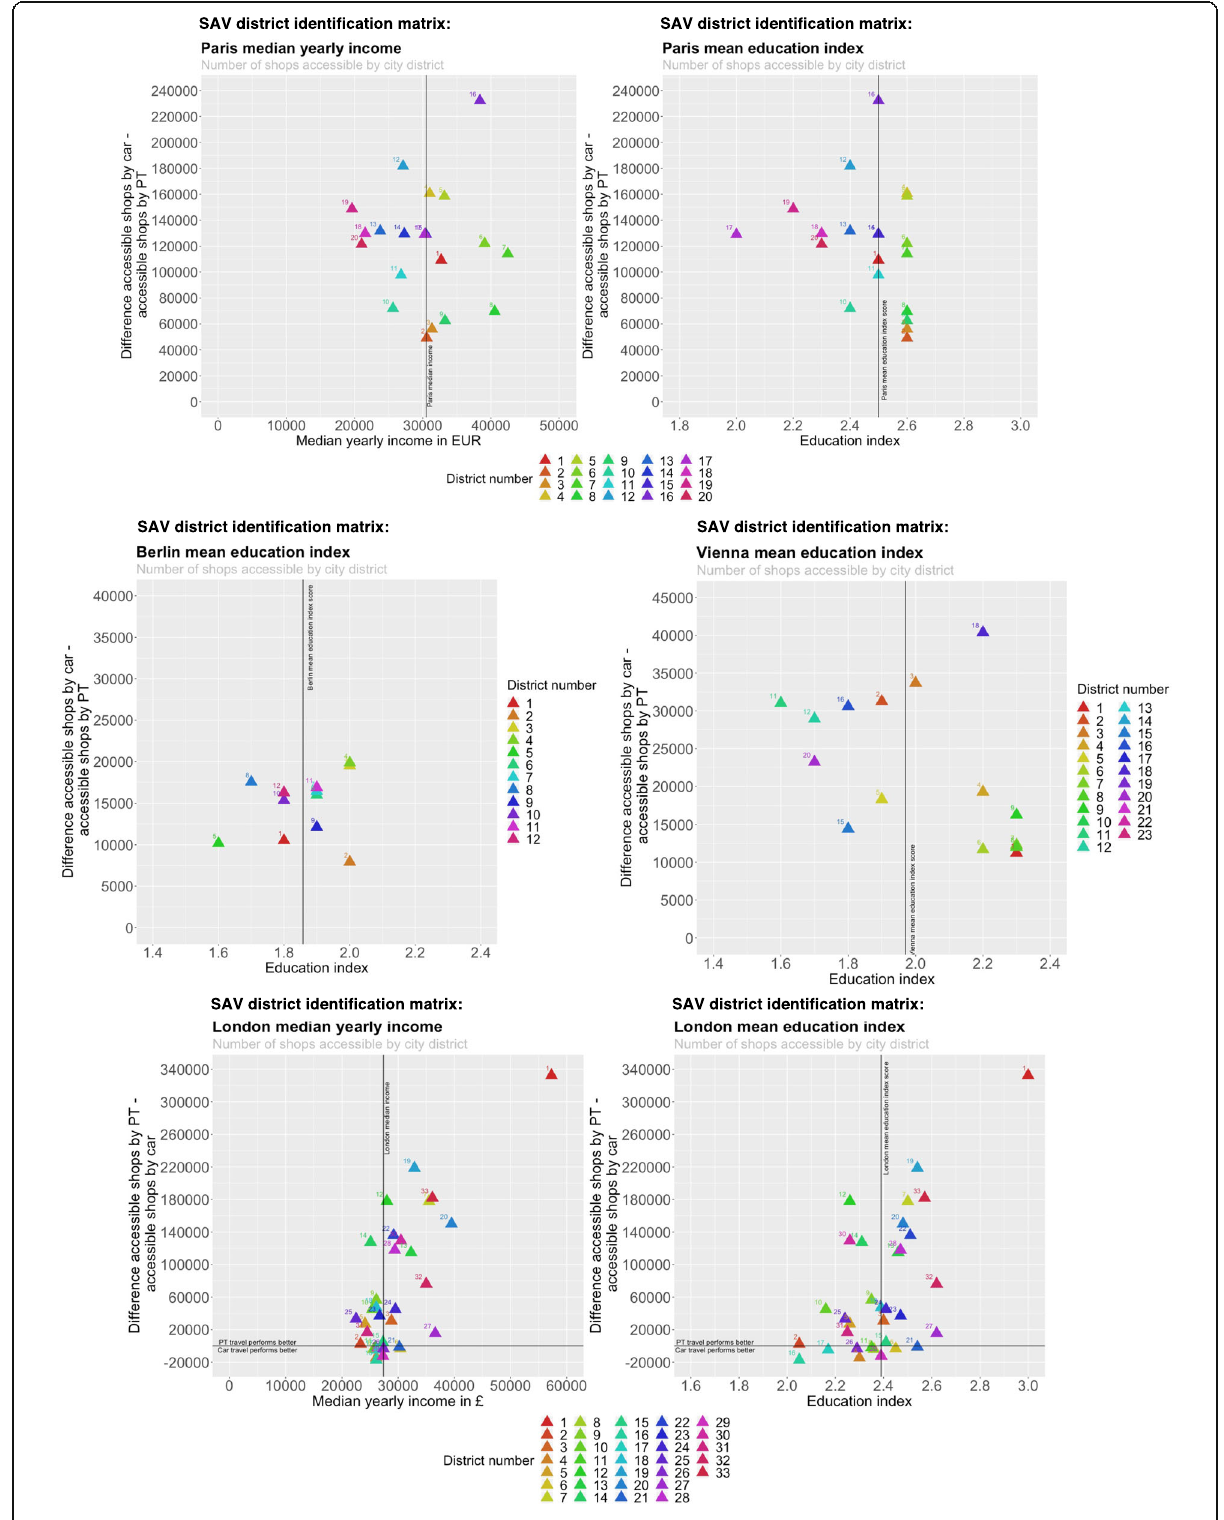
Fig. 3 SAV district identification matrixes per